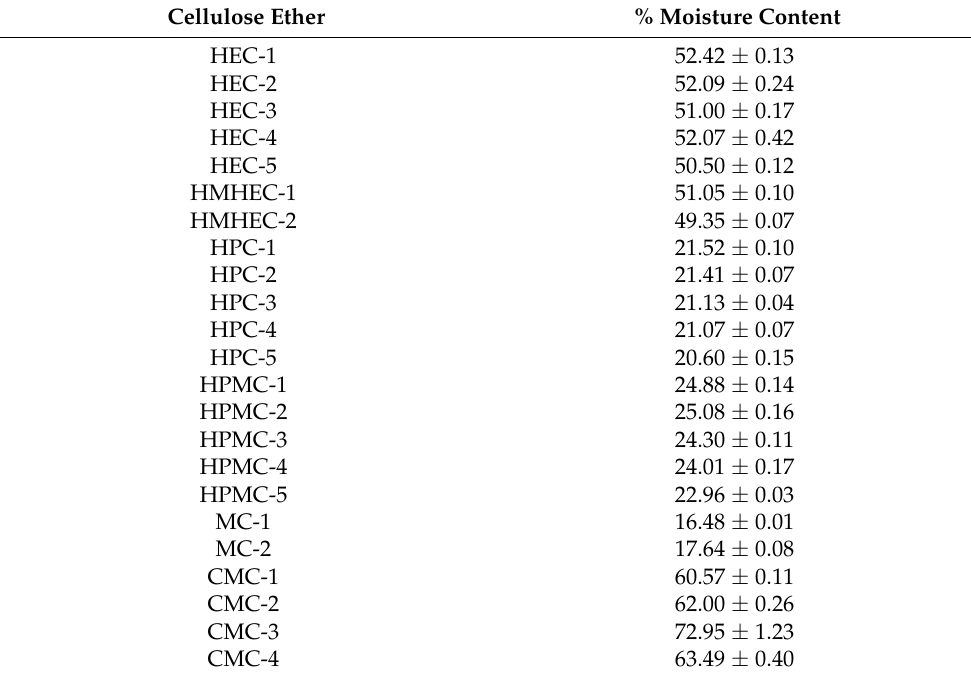
Table 5. Vapor sorption data of cellulose